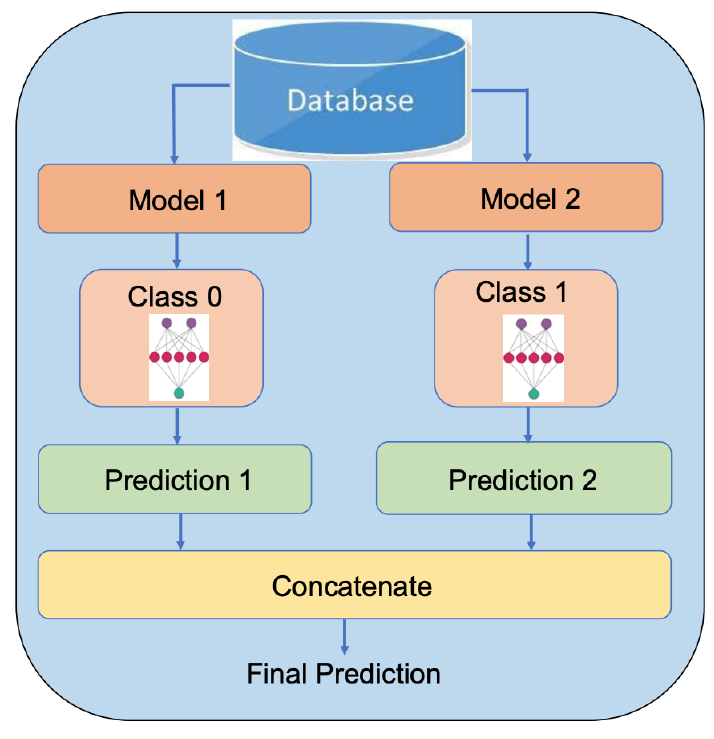
Figure 2. The ensemble learning model.